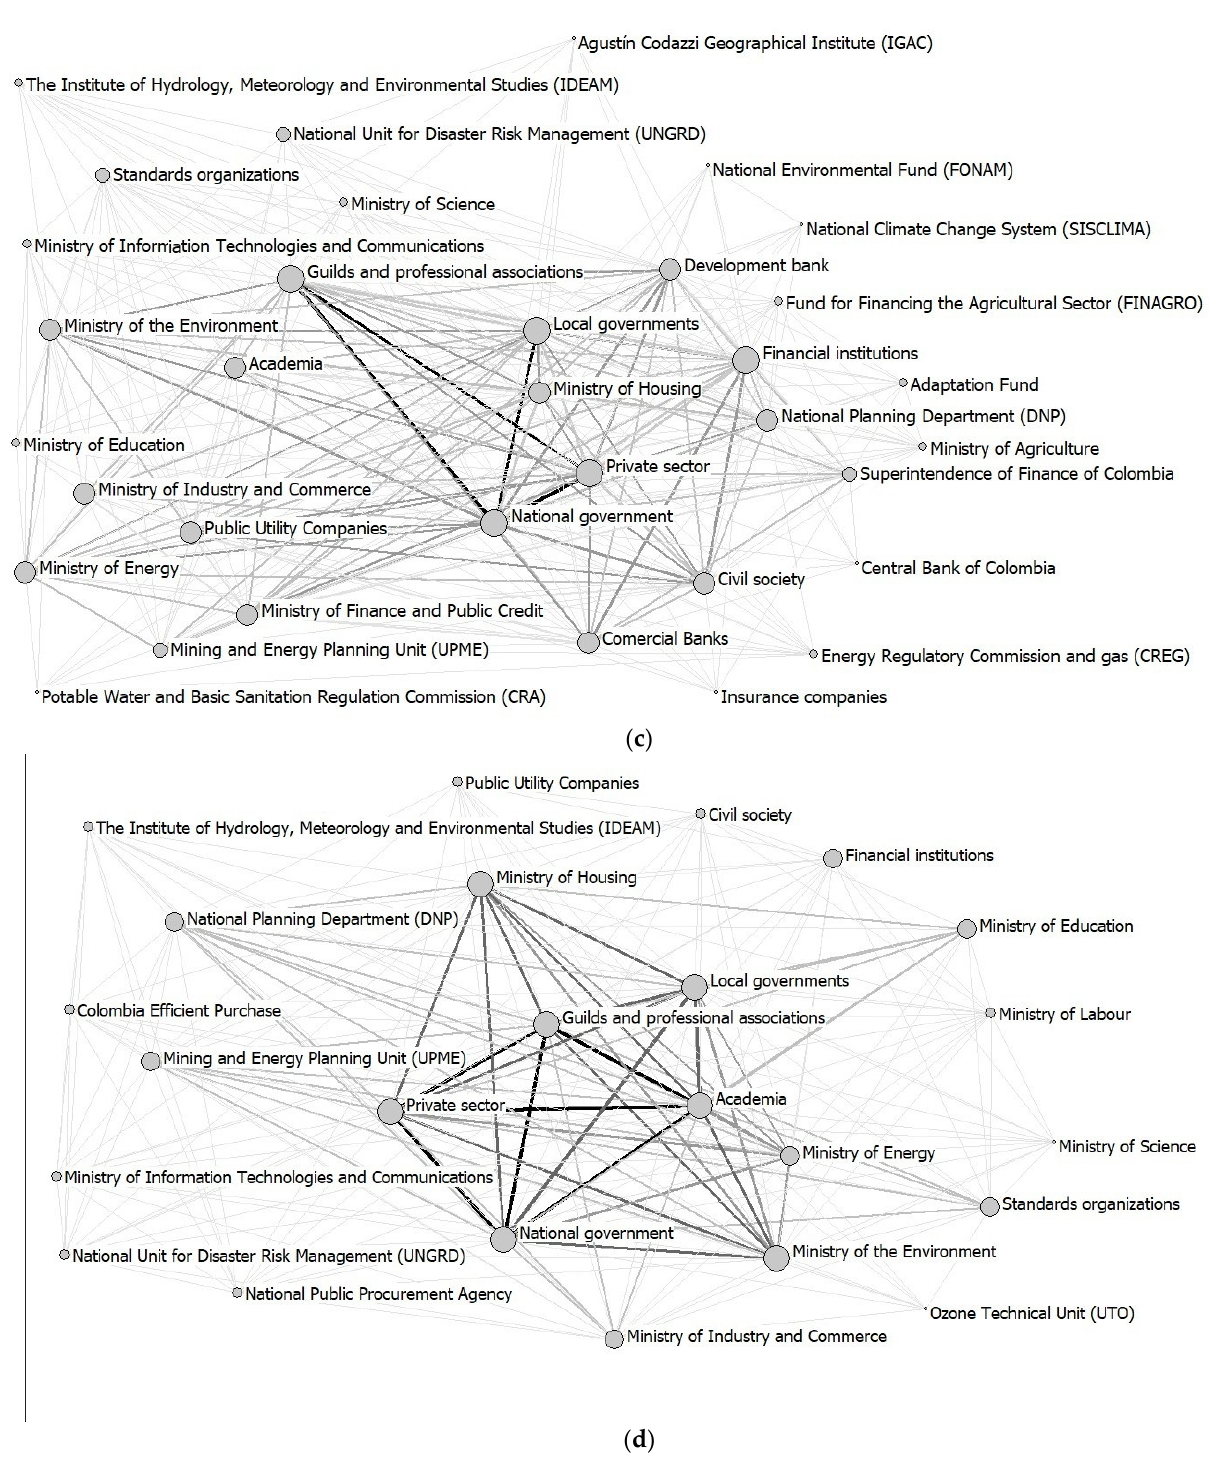
Figure 3. ( a ) Public policy network; ( b ) technology network; ( c ) finance network; and ( d ) capacity development network . Table 6. Network-based metrics per enabler.